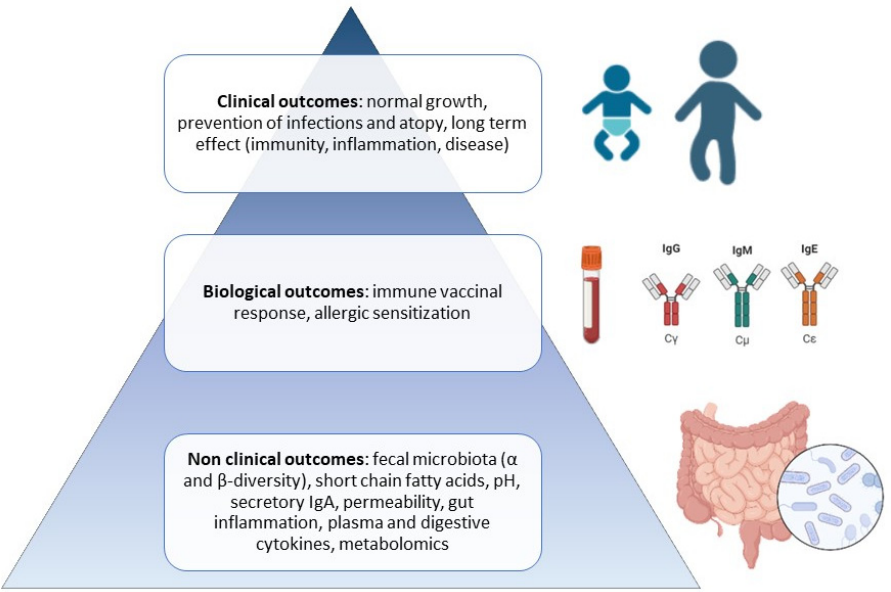
Figure 1. Pyramid of preclinical and clinical expected outcomes of pre-, pro-, syn-, and postbiotics during infancy.